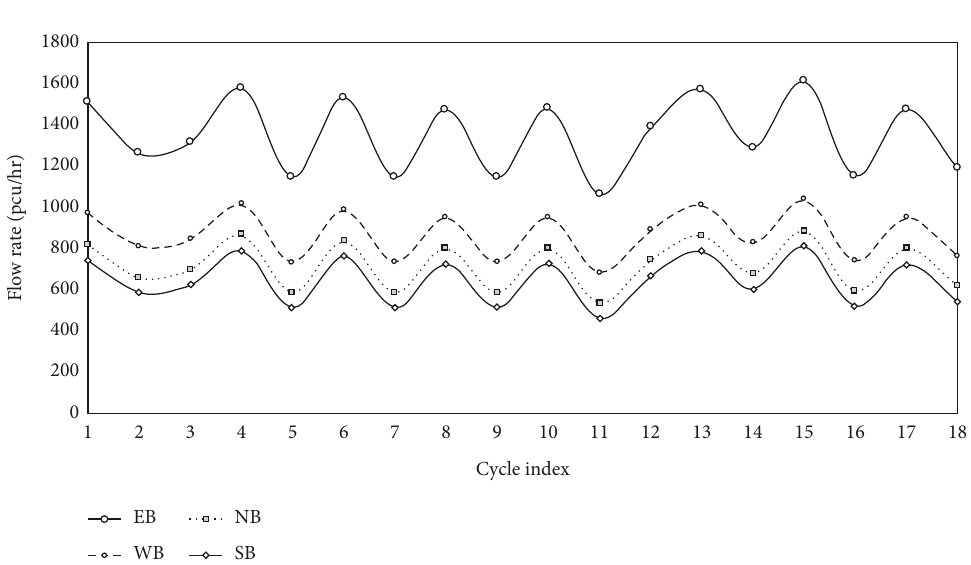
Figure 5: Variation of flow rate of critical phases of the major corridor. Table 3: Input parameters for implementation.